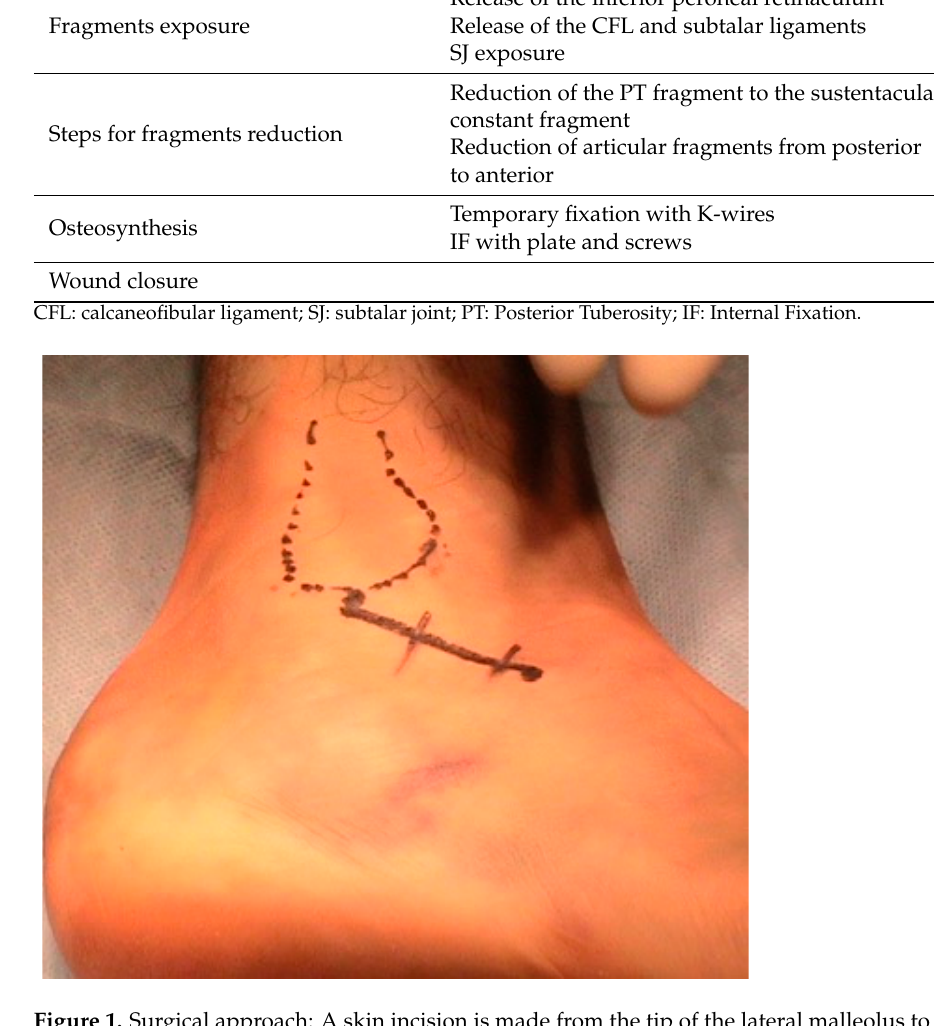
Figure 1. Surgical approach: A skin incision is made from the tip of the lateral malleolus to the base of the fourth